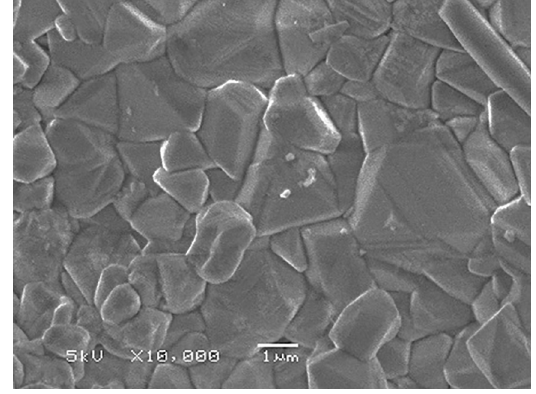
Figure 8. Scanning electron micrograph of sintered body. Table 2. Technical properties of the casted